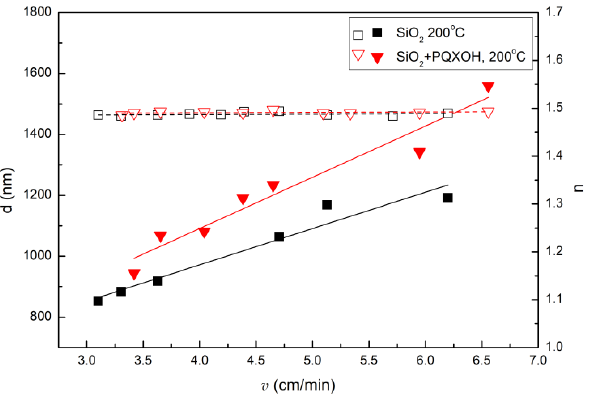
Figure 6 . Technological characteristics of the produced films of silica (SiO 2 ) and silica with PQXOH dye (SiO 2 + PQXOH) on soda-lime glass substrates. All layers were annealed at the temperature of 200 °C for 1 h.